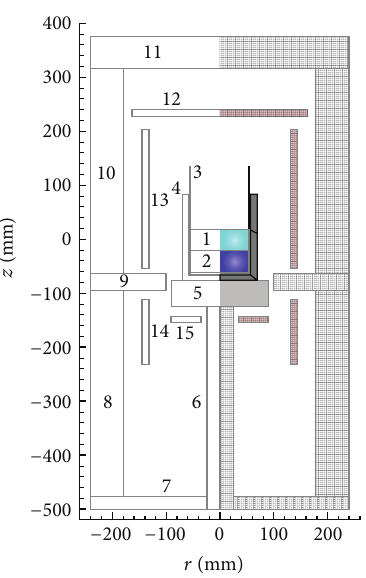
Figure 2: Position of the crucible (a) at the beginning of solidifica- tion and (b) at the end of